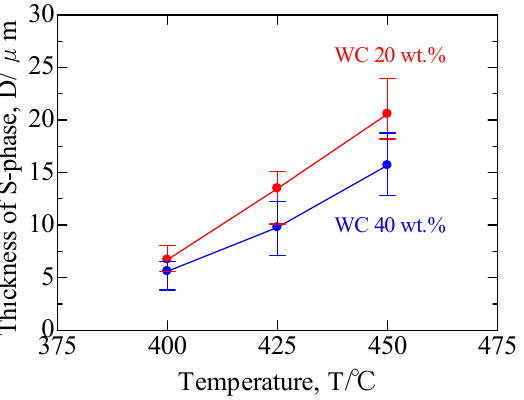
Figure 5. Thickness of the S-phase layers with various WC compositions and nitriding temperatures.